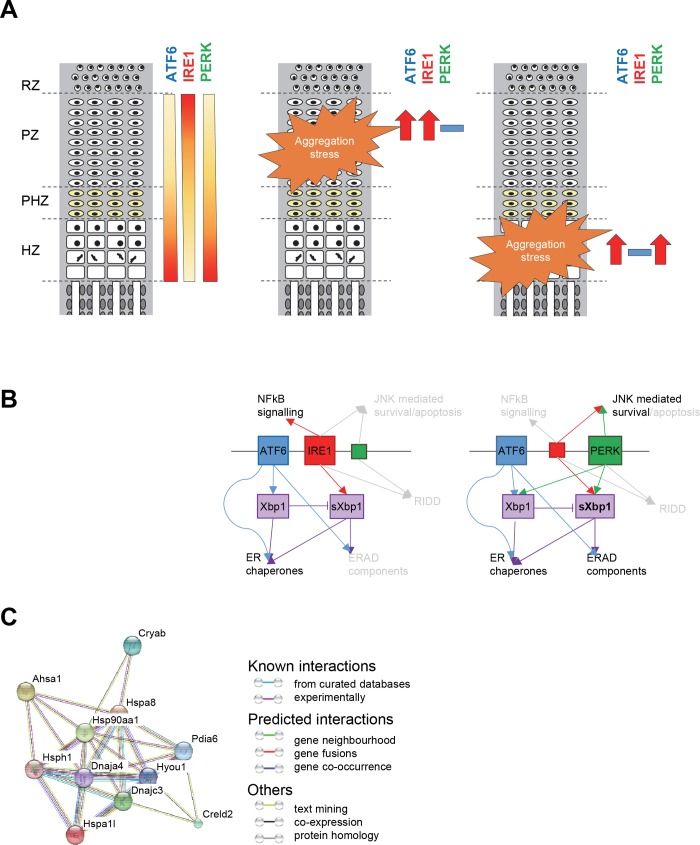
(A) Schematic explaining the basal levels of expression of the UPR sensors in the different zones of the cartilage growth plate and their differential expression upon the protein aggregation insult. (B) A schematic presenting the cross-talk of the UPR signalling branches upon misfolded protein aggregation in the proliferative (EDM5) and hypertrophic (MCDS) zones. (C) STRING visualisation of XBP1 modulated genes differentially expressed in the 5 day old EDM5 cartilage compared to the wild type control showing the postulated “aggregosome”.